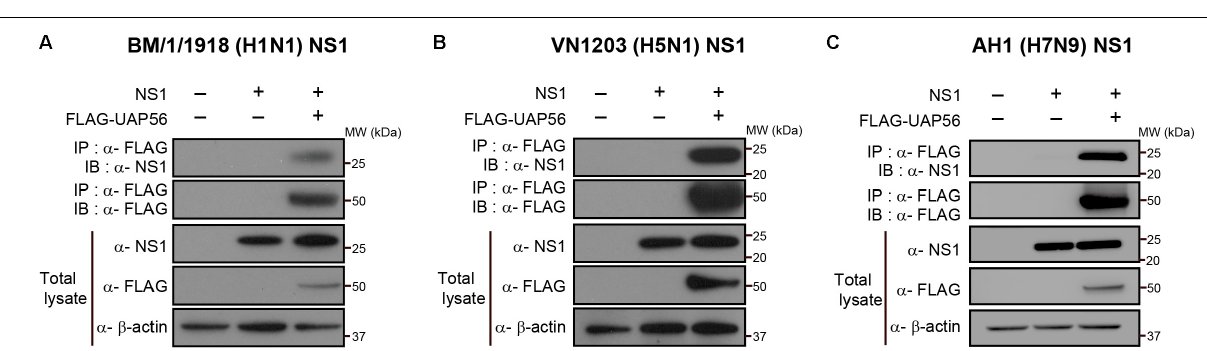
FIGURE 2 | UAP56 interacts with NS1 proteins derived from different influenza A viruses. HEK293T cells were transfected with plasmids expressing FLAG-tagged UAP56 proteins and/or the NS1 proteins of A/Brevig Mission/1/1918 (H1N1; BM/1/1918) (A) , A/Vietnam/1203/2004 (H5N1; VN1203) (B) , or A/Anhui/1/2013 (H7N9; AH1) (C) . At 48 h post-transfection, the cells were lyzed and immunoprecipitated with anti-FLAG M2 antibody-conjugated magnetic beads. Co-precipitated proteins were analyzed by immunoblotting with anti-NS1